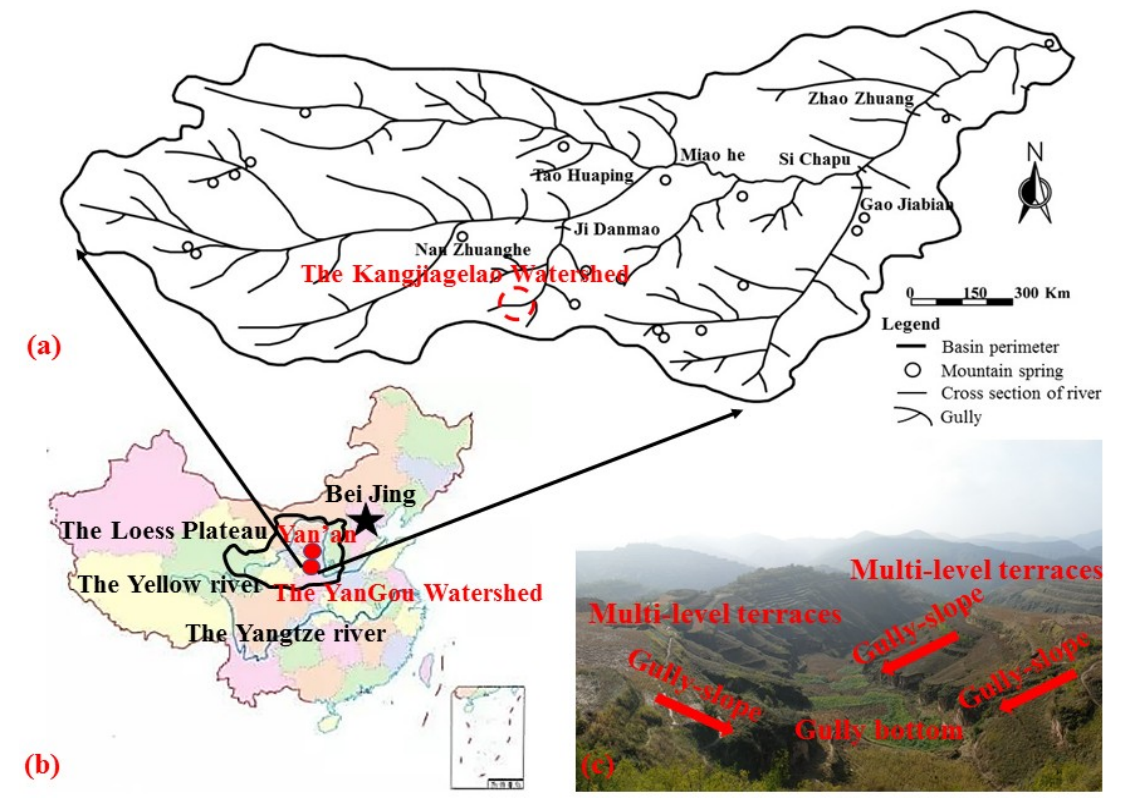
Figure 1. Location and different stages of the Kangjiagelao watershed; ( a , b ) location and early status of the Kangjiagelao watershed, ( c ) current status of the Kangjiagelao watershed.